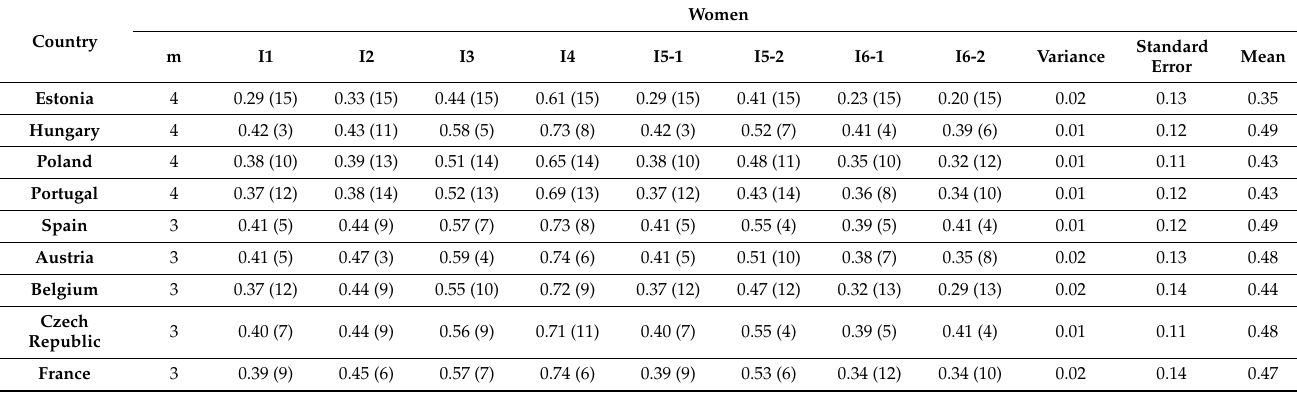
Table 8. Inequality indicators in self-perceived health in Wave 4 (2010) for